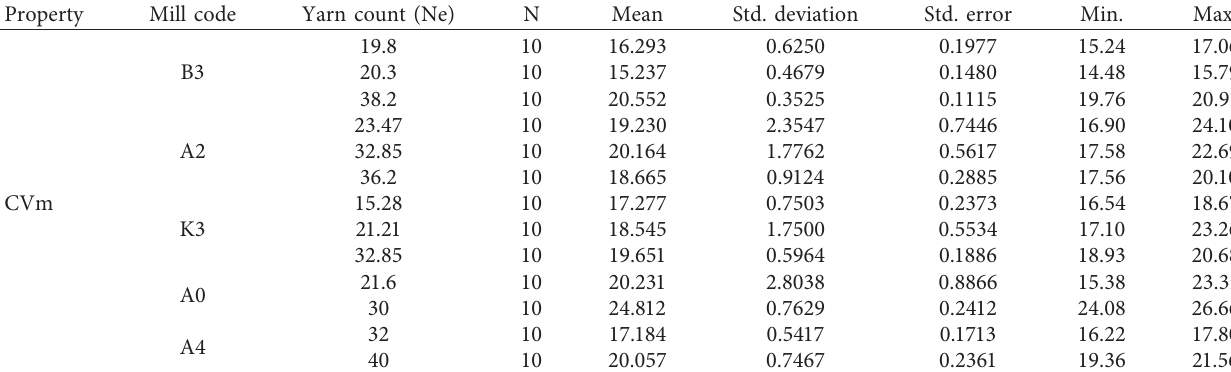
Table 3: Descriptive analysis of yarn